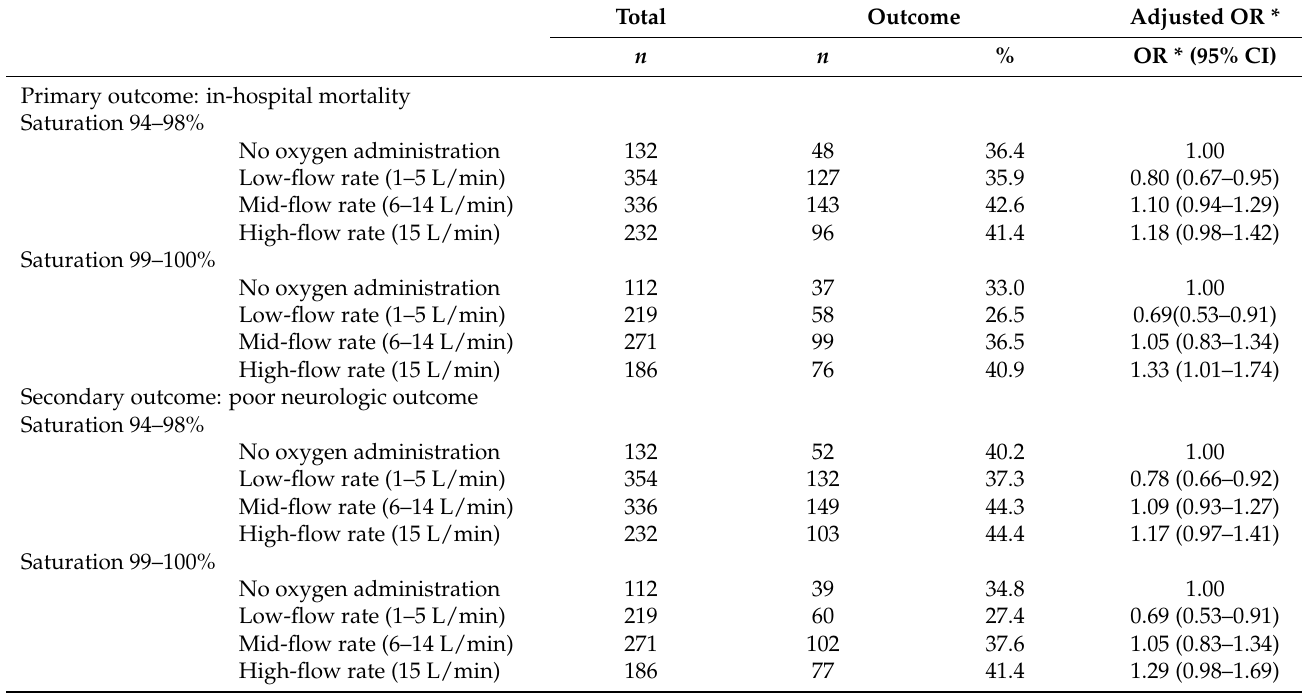
Table 4. Interaction analysis for clinical outcome according to oxygen flow rate by initial prehospital oxygen saturation